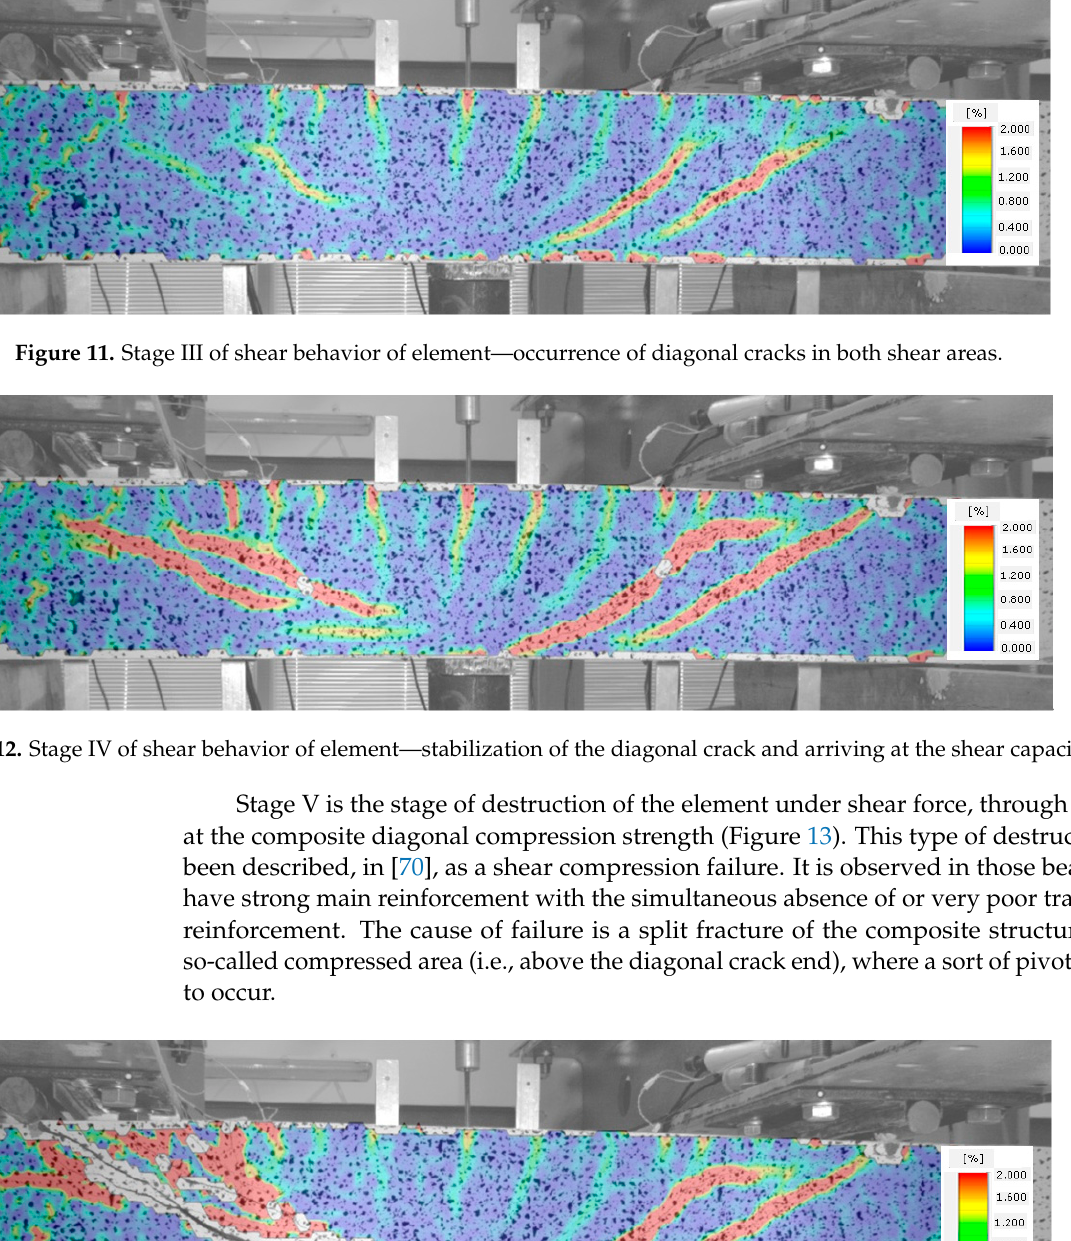
Figure 13. Stage V of shear behavior of element—shear compression failure of the beam.